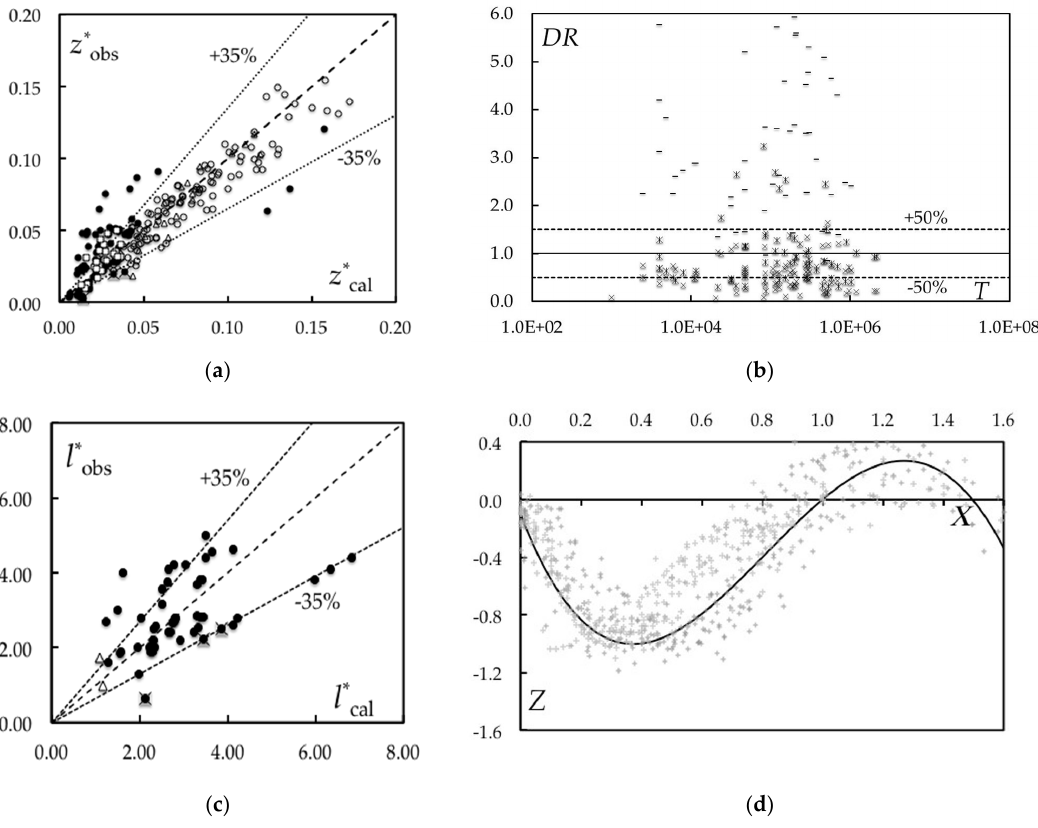
Figure 3. ( a ) Comparison between observed (subscript “obs”) and calculated (“cal”) values of z * for the data collected at the University of Basilicata ( ) with cross symbol indicating gravel and the data by: Gill [6] ( ), Webby [2] ( ), and Dey and Raikar [3] ( ). The values of z * are in meters; ( b ) discrepancy ratio ( DR ) as a function of the dimensionless time T for Laursen’s [5] ( ), Gill’s [6] ( ), and Lim’s [7] (–) formulas; ( c ) comparison between observed and calculated values of l * for the data collected at the University of Basilicata ( ) with cross symbol indicating gravel and by Webby [2] ( ). The values of l * are in meters; ( d ) comparison between observed axial bed profiles (+) and Equation (7) (full curve).